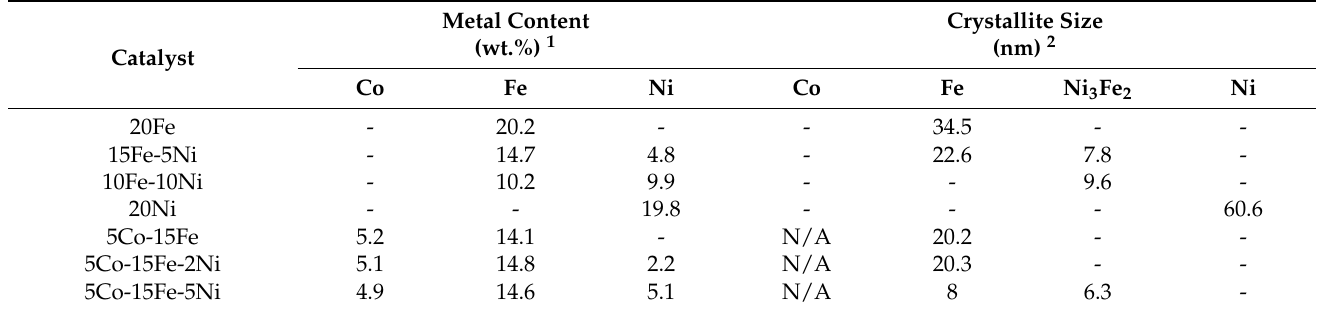
H 2 -temperature-programmed reduction (H 2 -TPR) was conducted to investigate the reducibility of monometallic and bimetallic catalysts. Figure 2 showed the TPR profiles of 20 wt.% monometallic catalysts and the 20 wt.% bimetallic catalysts. The 20Fe/ γ -Al 2 O